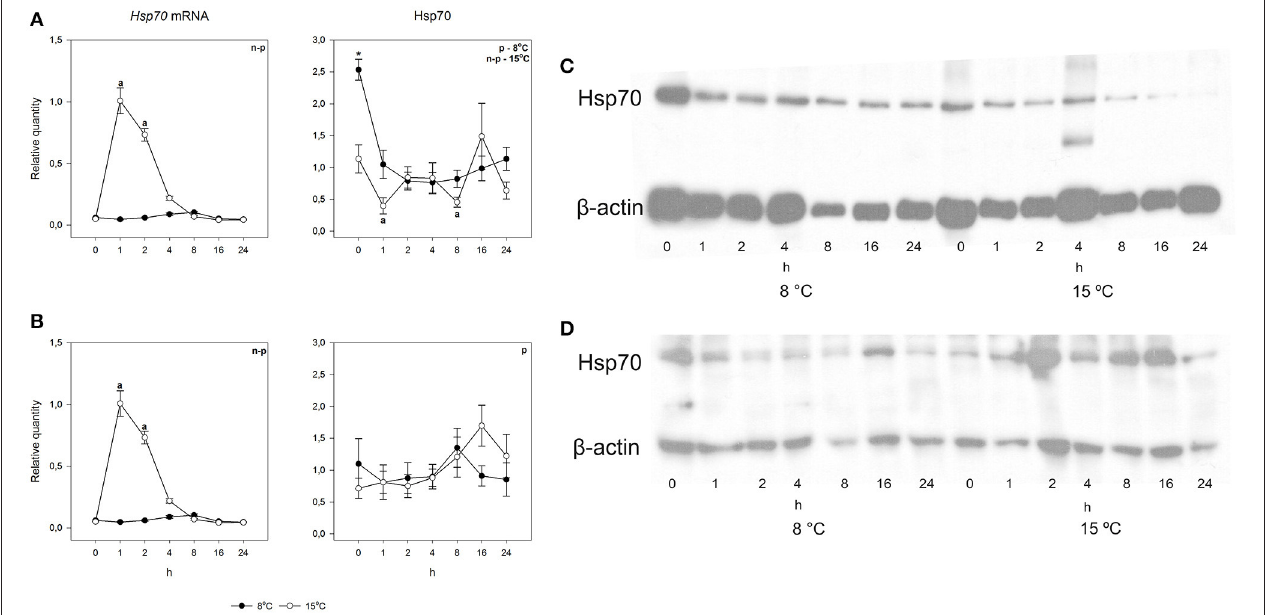
FIGURE 6 | Time course of heat shock induced hsp70 mRNA and protein synthesis in Atlantic salmon. Relative quantities (mean ± SEM, n = 7) in (A) gills and (B) liver. Relative quantities of hsp70 are based on hsp/ β -actin ratios in the western blots. Representative examples of western blots for gills are given in (C) and liver in (D) . Whenever ANOVA or Kruskal-Wallis on ranks [parametric (p) or non-parametric (n-p), respectively] indicated statistically significant differences post-hoc testing (Dunnett’s method) was conducted. A letter above a symbol indicates that the values at that time point are significantly different from the values before the heat shock. *above the symbol in the hsp70 data of gills indicates the one significant difference found in cold-acclimated fish ( p <